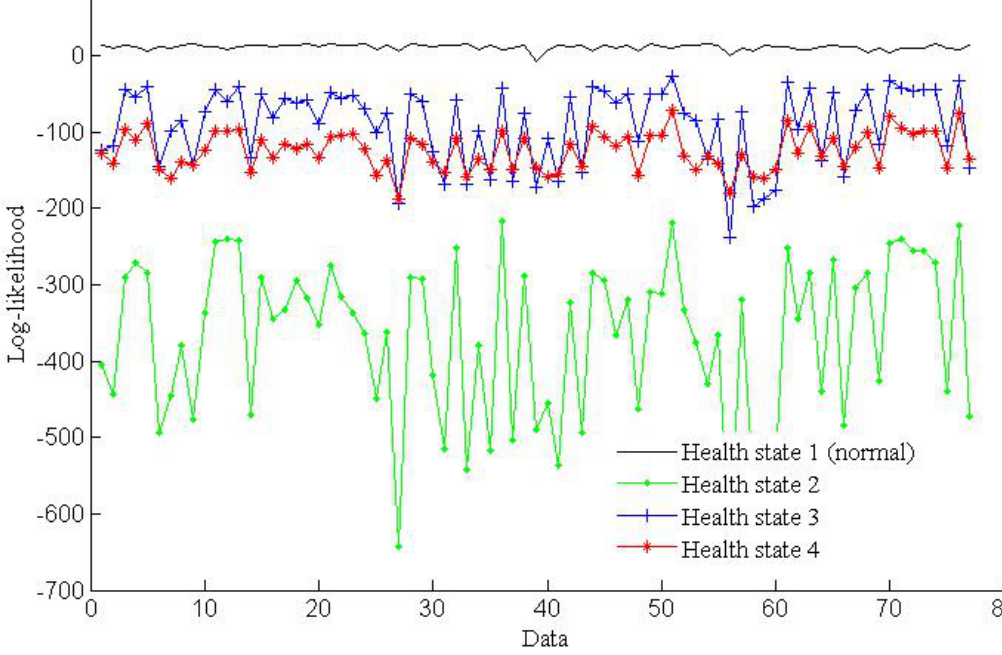
Figure 8. Log-likelihoods for the four state HMMs of the fault-free test data.